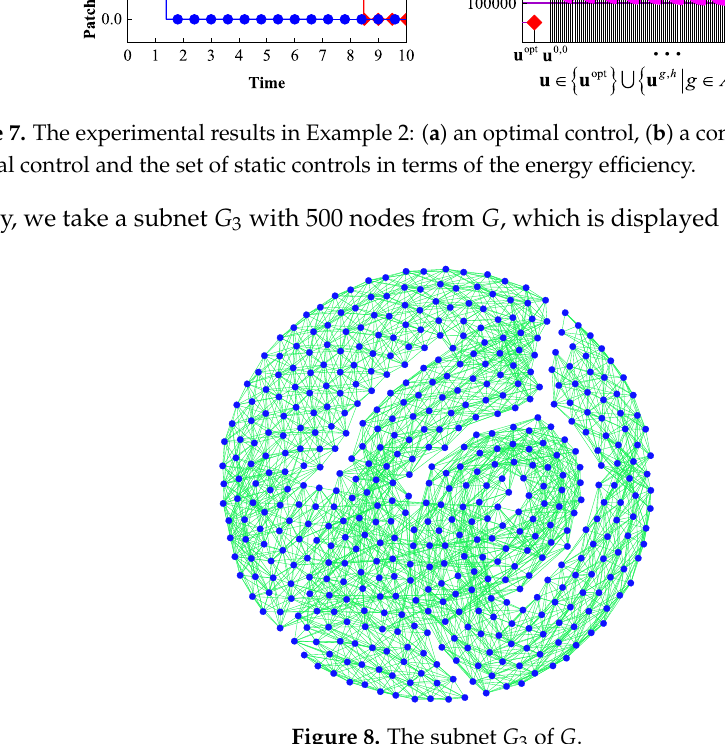
Figure 8. The subnet G 3 of G